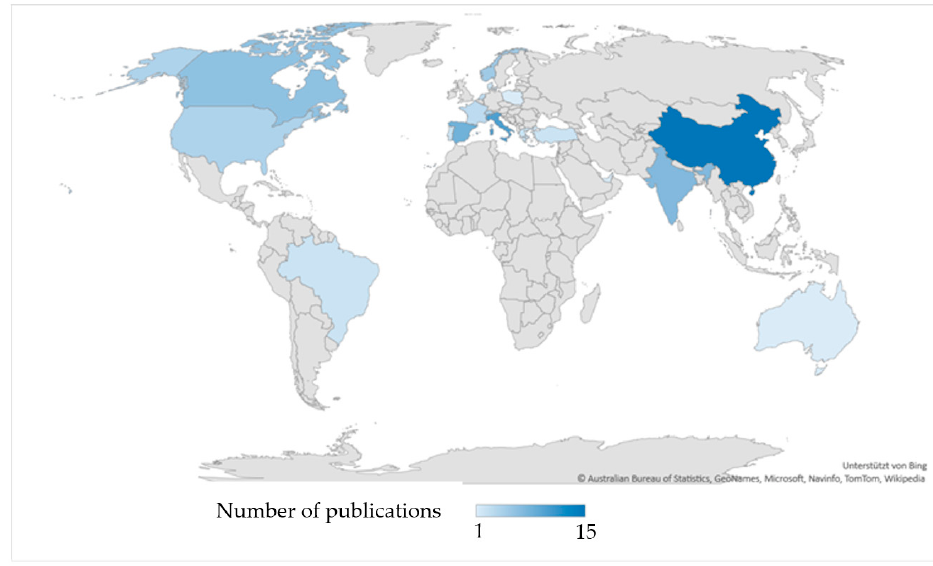
Figure 6. Geographical distribution of publications.